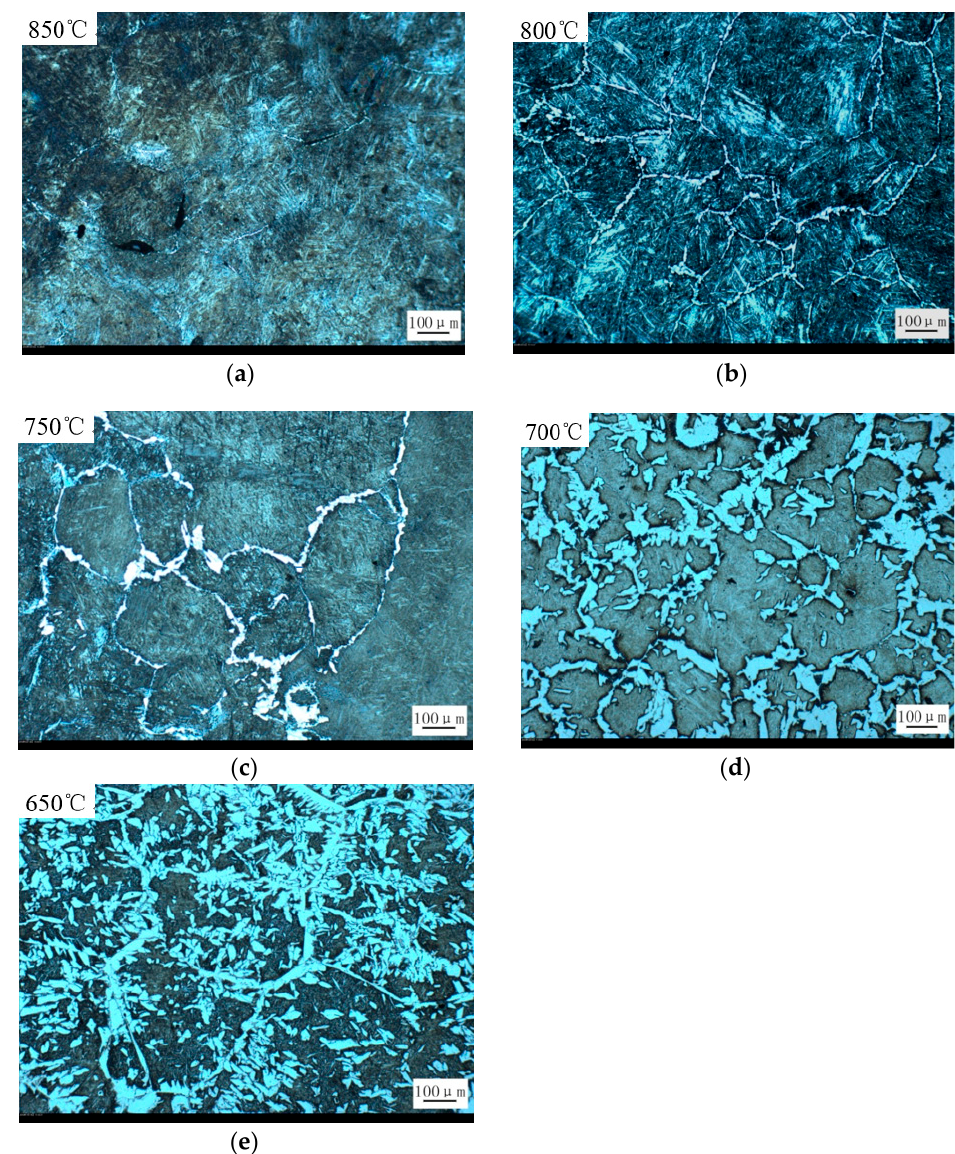
Figure 9. Fracture microstructures from the tensile test at different temperatures. ( a ) 850 °C, ( b )800 °C,( c )750 °C, ( d ) 700 °C,( e ) 650 °C.